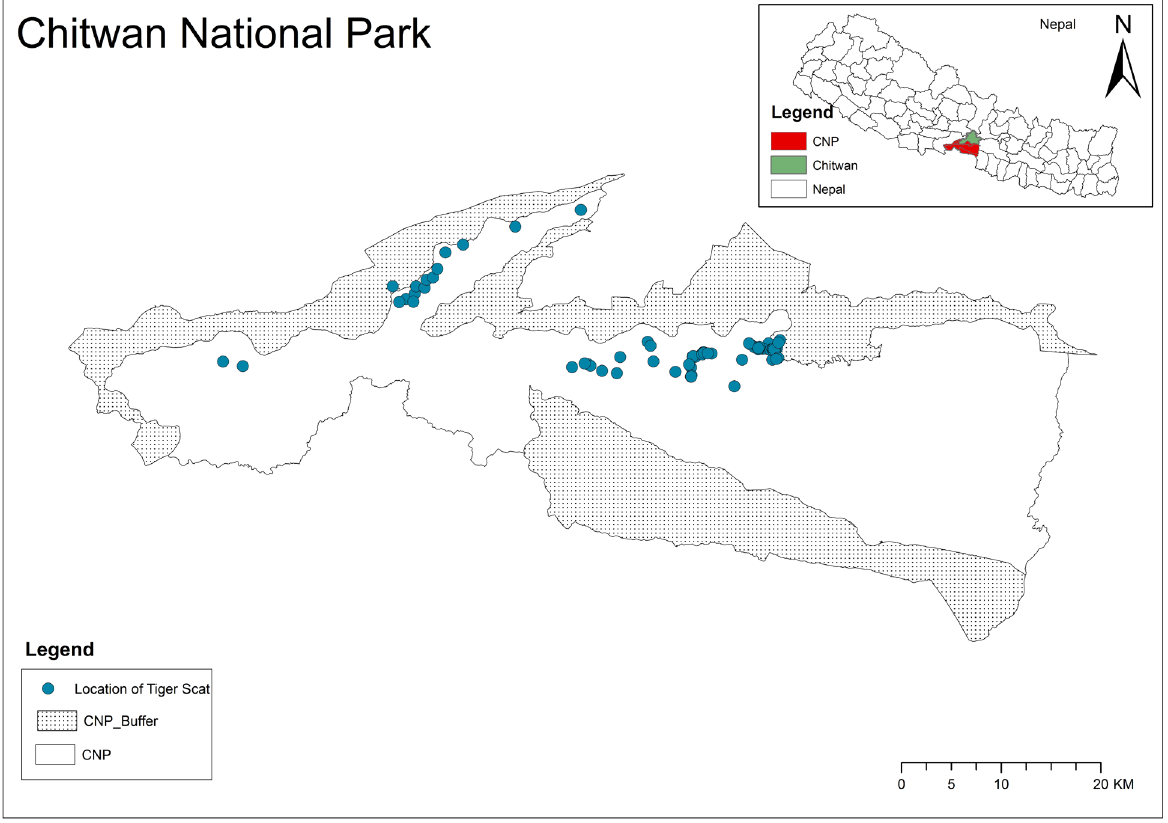
Figure 1. Chitwan National Park and its buffer zone (www.dnpwc.gov.np, 2011). The dots in the map represent GPS locations for scat samples collected during the